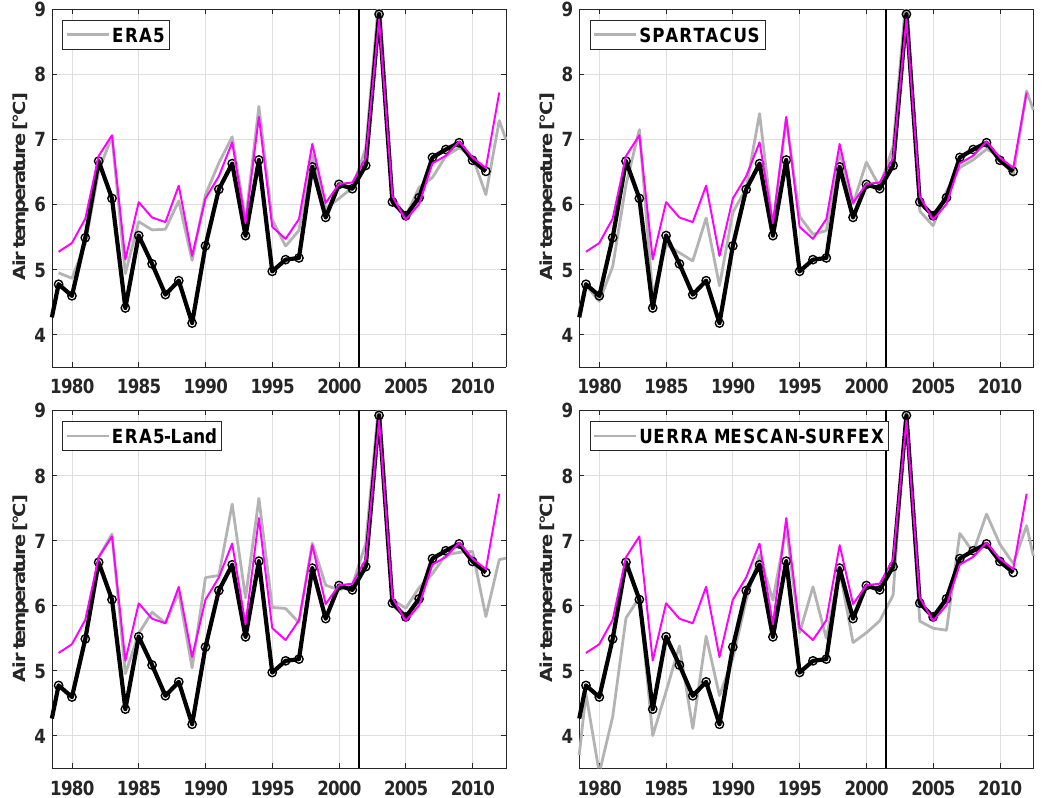
Figure 8. VERNAGT summer (JJA) air temperatures: observations (black), sDoG (magenta), and the reference data sets ERA5, SPARTACUS, ERA5-Land and UERRA MESCAN-SURFEX (in grey). Note that for this figure the summer time series of the reference data sets are standardized to obs-training, because the emphasis is on season-to-season co-variability here (see Section 2.3). The performance in simulating the seasonal cycle is then illustrated separately in Figures 9 and 10.